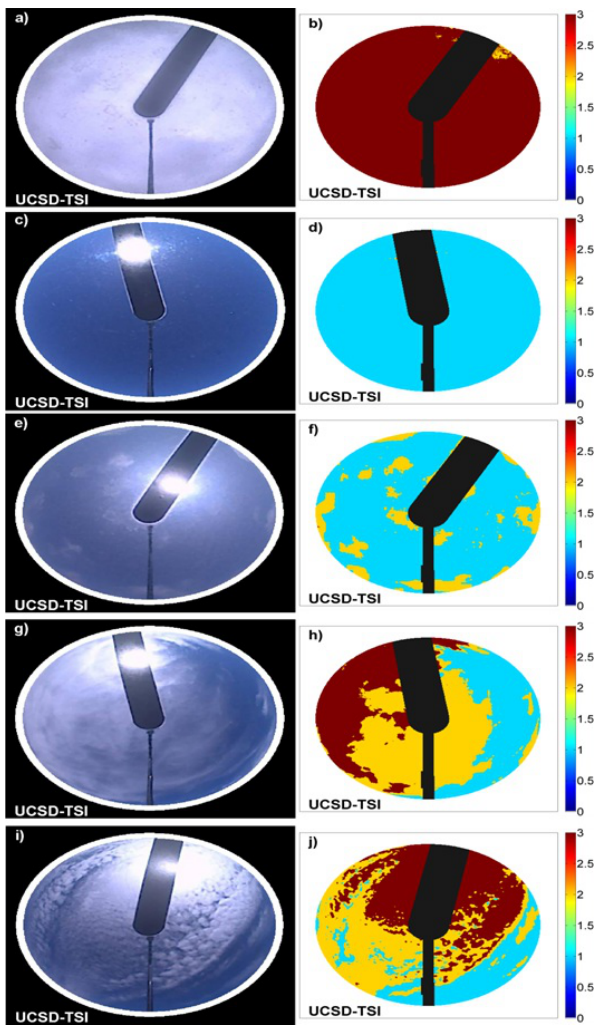
Fig. 9. Total sky image (a, c, e, g, i) and CDOC (b, d, f, h, j) for: (1) overcast skies (a, b) taken on 20 April 2011 and corresponding to image 15 in Table 4; (2) clear skies (c, d) taken on 12 February 2011 and corresponding to image 16 in Table 4; (3) few thin clouds (e, f) taken on 19 April 2011, and corresponding to image 12 in Table 4; (4) partly cloudy skies (g, h) , (i, j) taken on 13 February 2011, and 14 February 2011, and corresponding to images 19 and 24 in Ta- ble 4, respectively. For the classification images, a value of 3 on the color scale represents thick clouds, 2 represents thin clouds, and 1 represents clear skies.